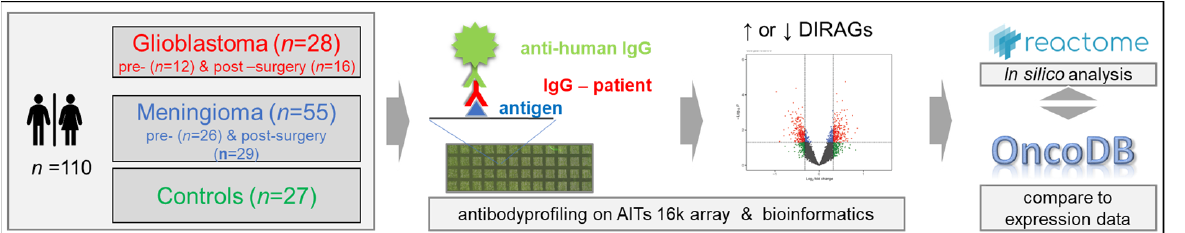
Figure 1. Schematic representation of the study design. The Medical University of Vienna provided 110 serum samples from preoperative and postoperative glioblastomas, meningiomas and matching cancer-free controls. IgG isolated from the samples was probed on AIT’s 16 k protein microarray, to elucidate differentially reactive antigens (DIRAGs) by class comparison of sera from tumor patients with controls, and from preoperative and postoperative samples. Lists of statistically significant antigens were then subjected to a Reactome pathway analysis [13], and were compared to glioblastoma gene expression data from OncoDB (http://oncodb.org/ accessed on 30 August 2022; [14]).